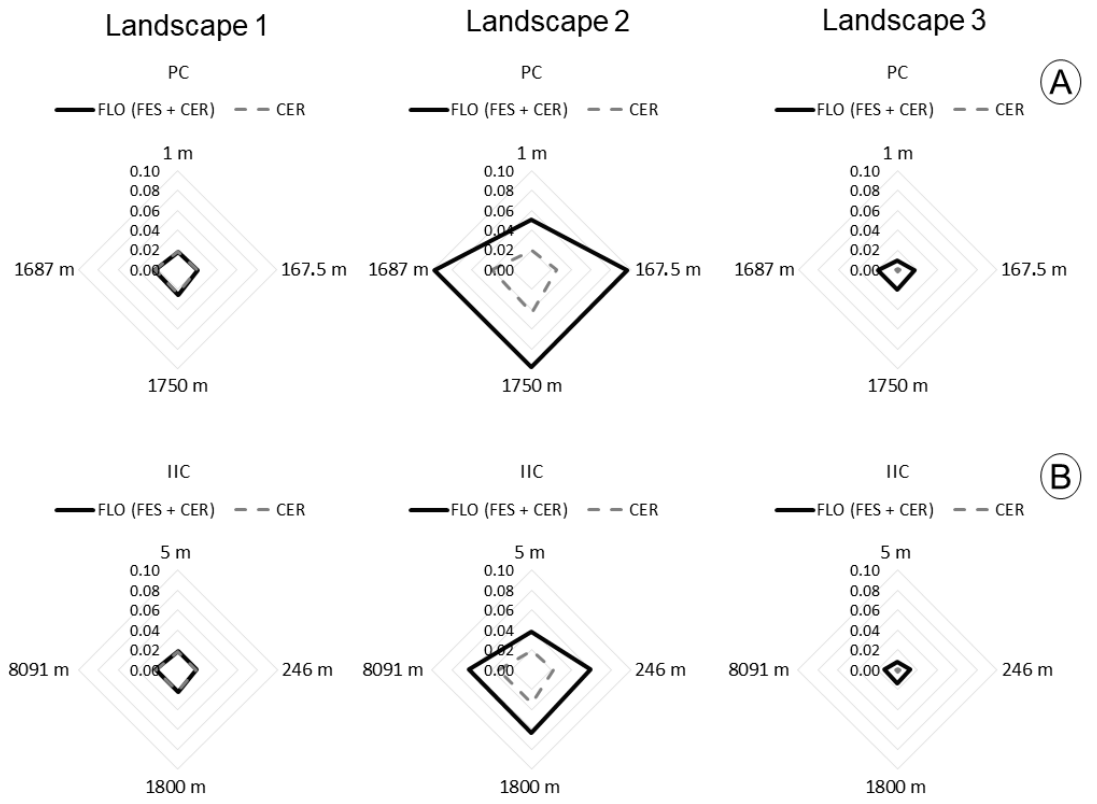
Figure A1. Measures of functional connectivity of the three landscapes in the four distance profiles of plant dispersal (short, medium, medium–long, and long) for all forest cover (FOR) and for cerradão (CER) only: ( A ) Probability of Connectivity (PC); ( B ) Integral Connectivity Index (IIC).